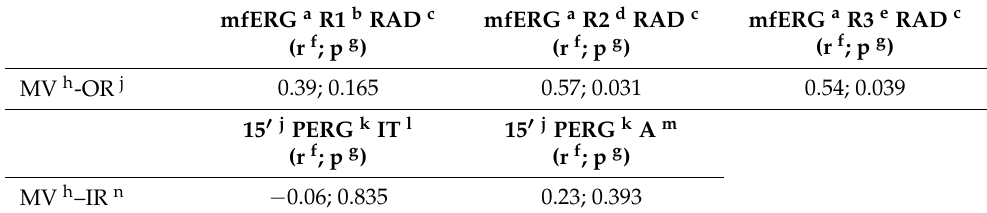
Table 3. Correlation between the morphological and functional values of the outer and inner macular region in carriers of Friedreich’s ataxia (C-FRDA).